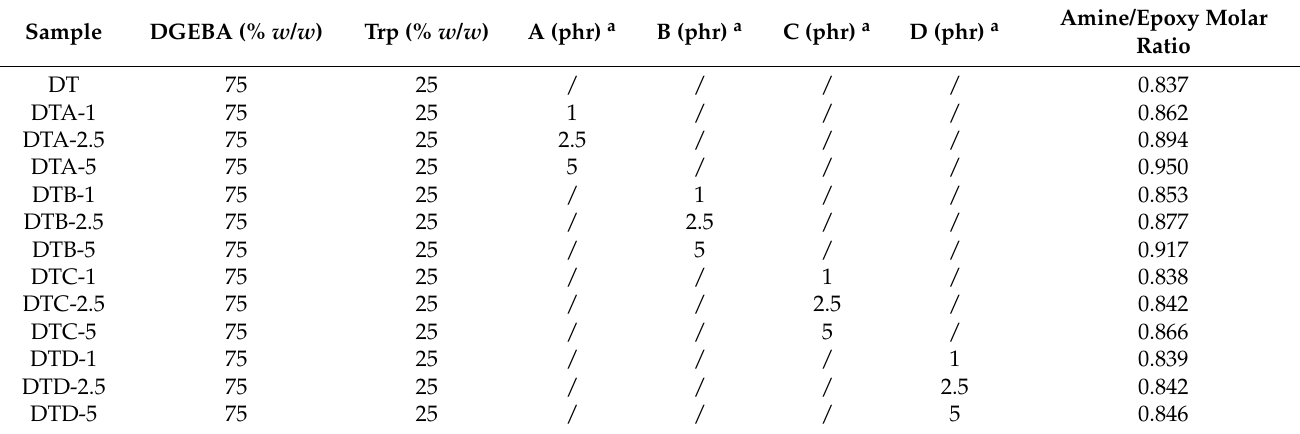
Table 1. Compositions of the different diglycidyl ether of Bisphenol A (DGEBA)/L-tryptophan investigated thermoset formulations.